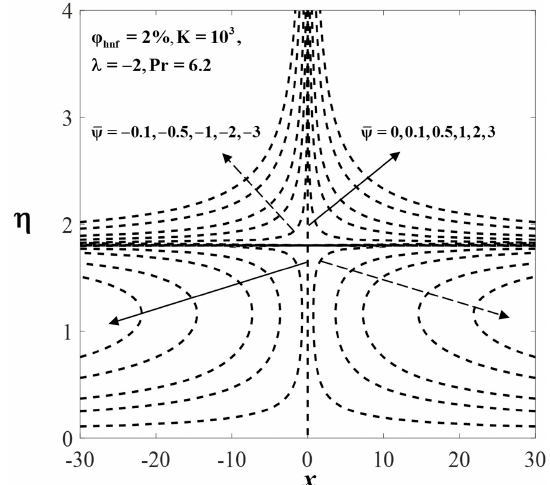
Mathematics 2021 , 9 , x FOR PEER REVIEW Figure 9. Streamlines for the second solution. Figure 9. Streamlines for the second solution. Figure 9. Streamlines for the second solution.